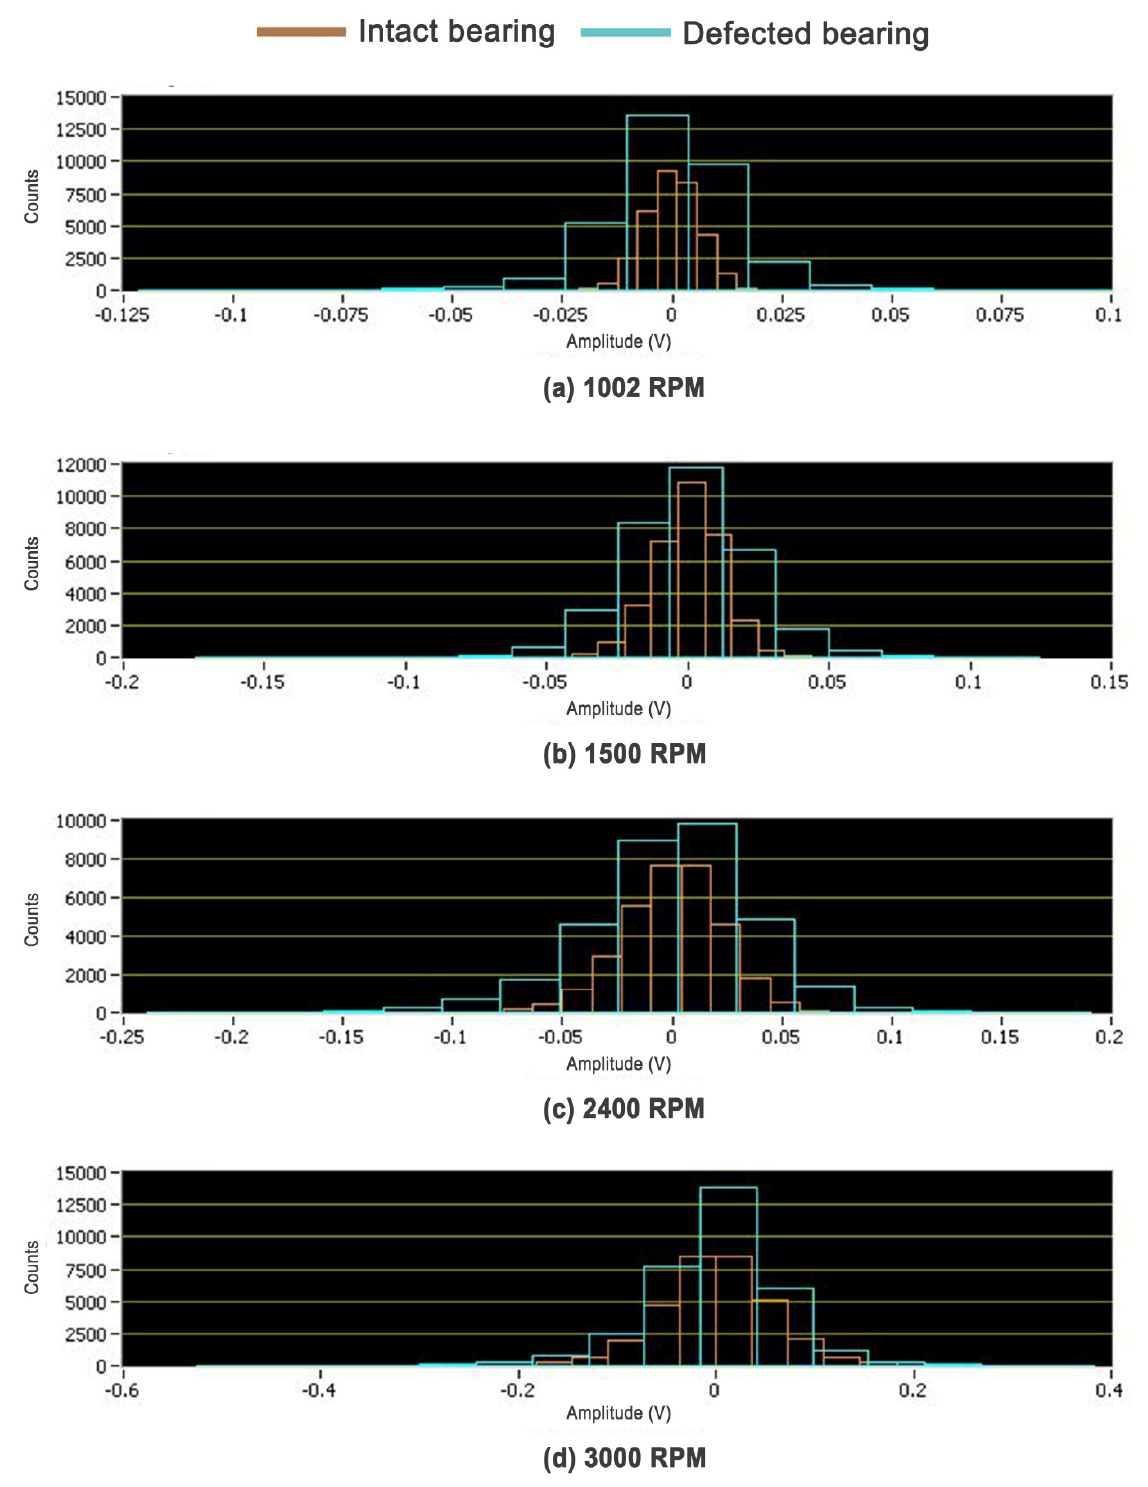
Figure 3. Histograms for an inner race damaged bearing with installing a bearing loader. From Figures 2 and 3, it can be seen that the bars are high for an inner race damaged bearing for both of the loading conditions. At all rotating speeds, the frequency of the inner race damaged bearing data is high as compared to the intact bearing data. The kurtosis values shown in Table 4 are also high in the case of an inner race damaged bearing for all rotating speeds. As the kurtosis values give a better idea of vibration energy at